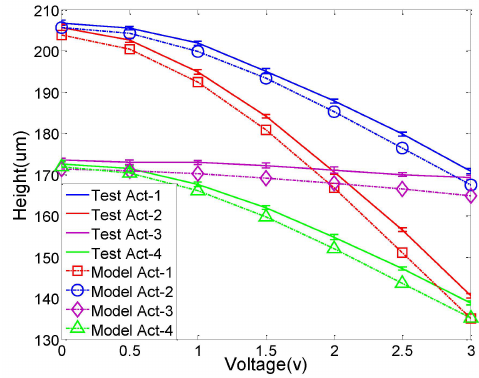
Figure 6. Plot of the experimental data and model prediction when the varying voltage is applied only to ACT1 and the voltages on ACT2, 3 and 4 are fixed at 1 V, 2 V and 2 V respectively.